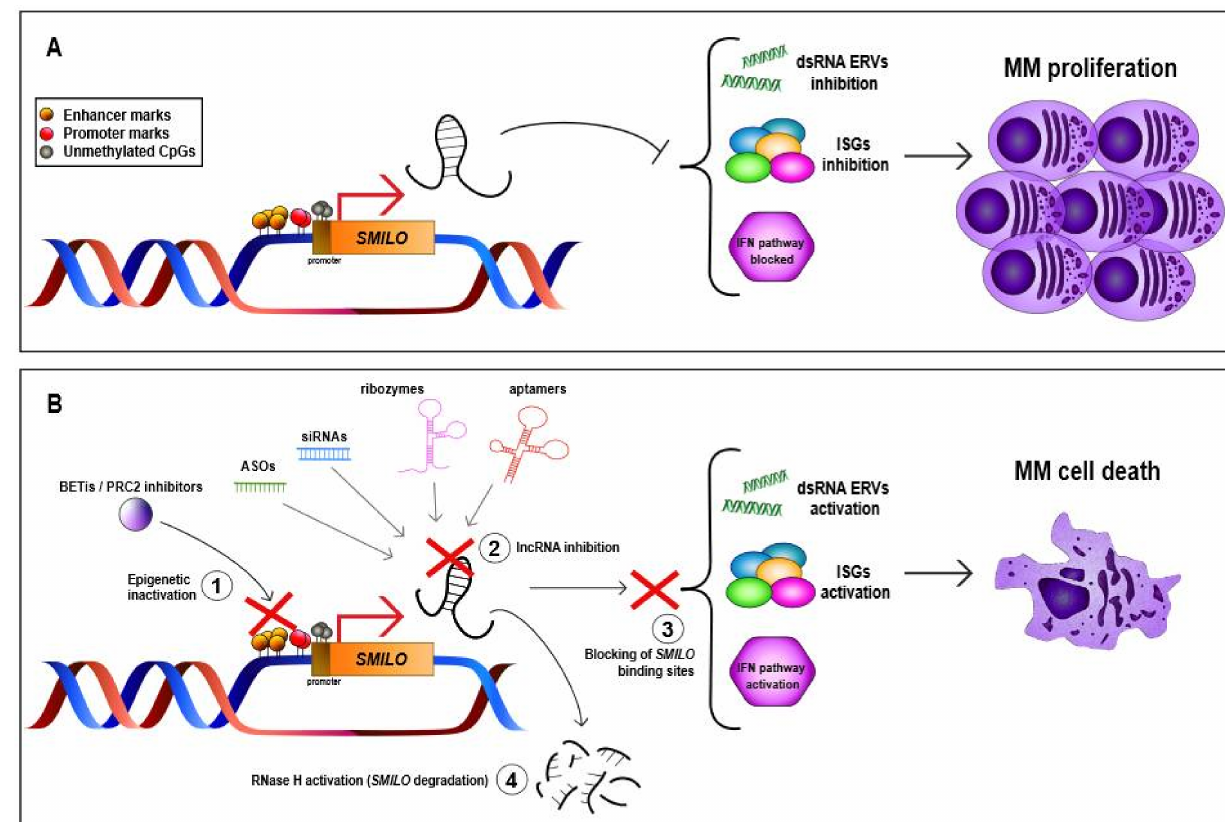
Figure 2. lncRNA-based strategies for MM treatment. ( A ) Gain of de novo active chromatin marks and DNA hypomethyla- tion of the SMILO promoter leads to its overexpression in MM cells, triggering the inhibition of ERVs and ISGs and blocking the IFN pathway, resulting in MM cell proliferation. ( B ) Different strategies based on lncRNA-targeted therapies to block the effect of SMILO overexpression in MM cells, triggering cellular death. dsRNA = double-stranded RNA; ERVs = endogenous retroviruses; ISGs = interferon-stimulated genes; IFN = interferon; MM = multiple myeloma; BETis = bromodomain and extraterminal inhibitors; PRC2 = polycomb repressive complex